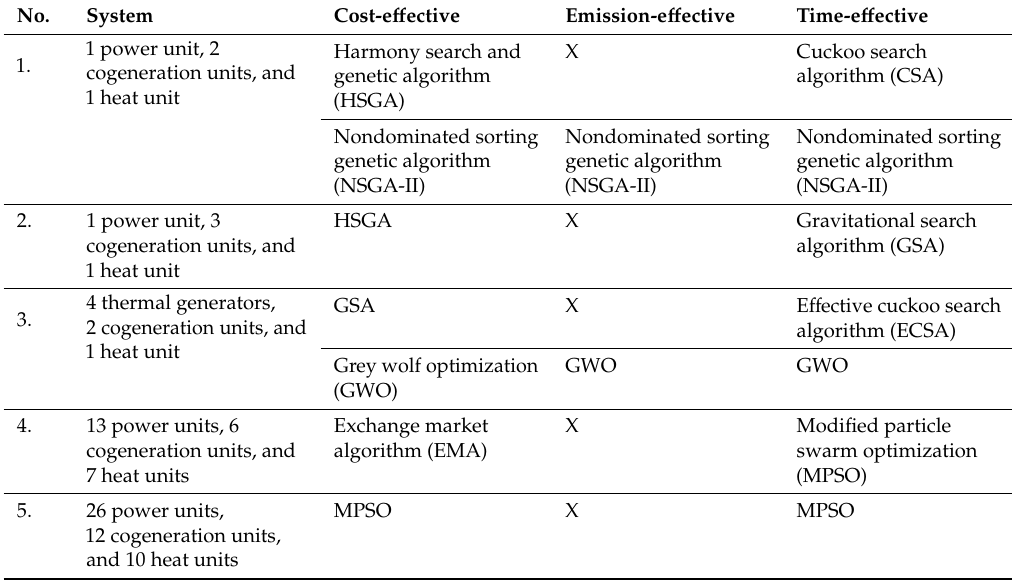
Table 1. Best optimization methods employed in di ff erent systems with regard to cost,